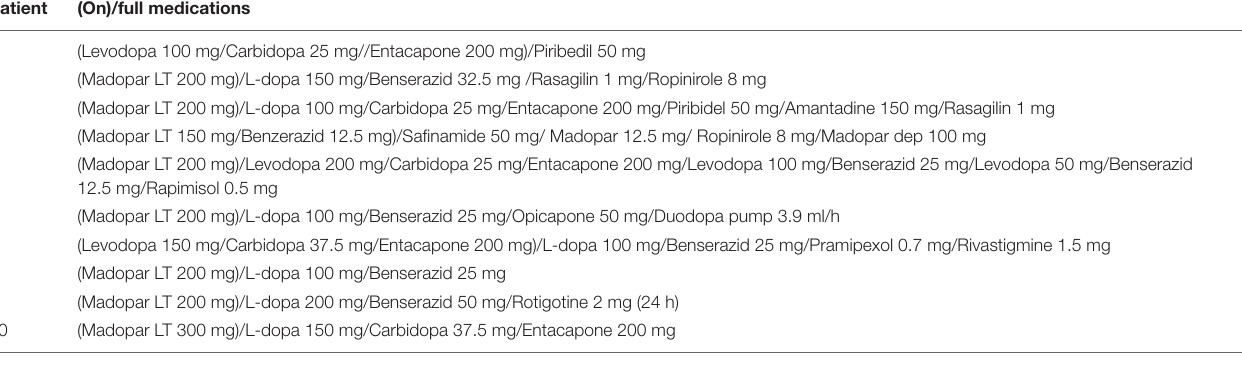
TABLE 2 | Full medications for each patient including dopaminergic medications used for the condition MED-ON. Patient (On)/full medications